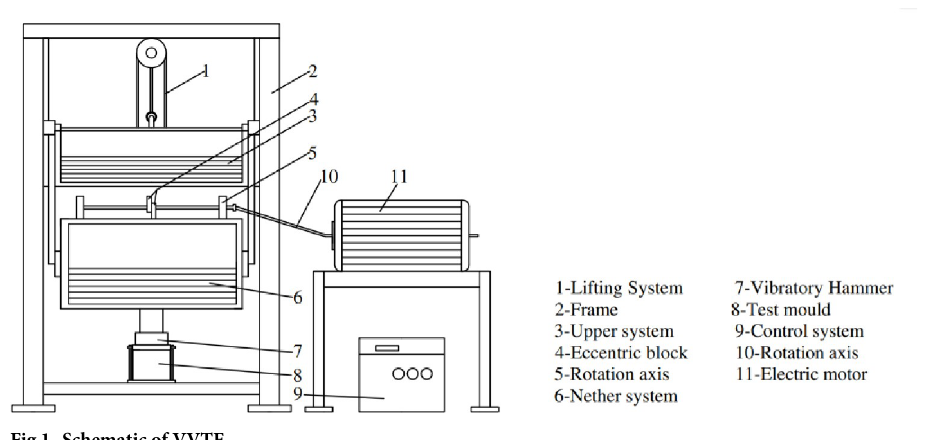
Fig 1. Schematic of